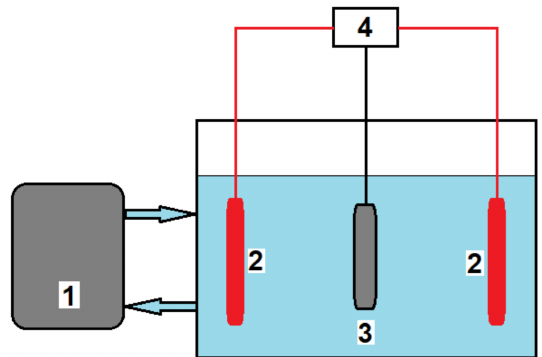
Figure 1. Schematic illustration of galvanic cell, wastewater electrolysis system, as